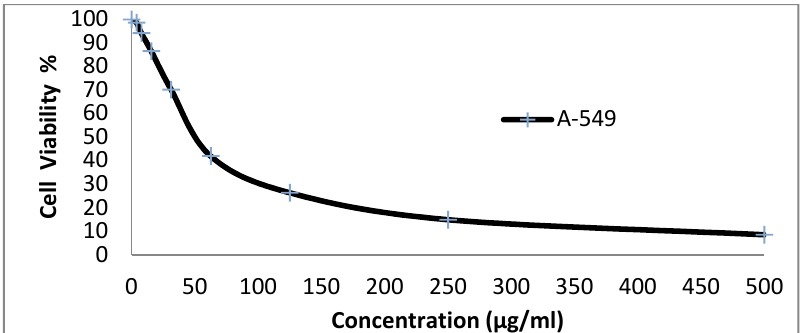
Figure 5. Evaluation of disperse dye 14x on cell line HCT-116.